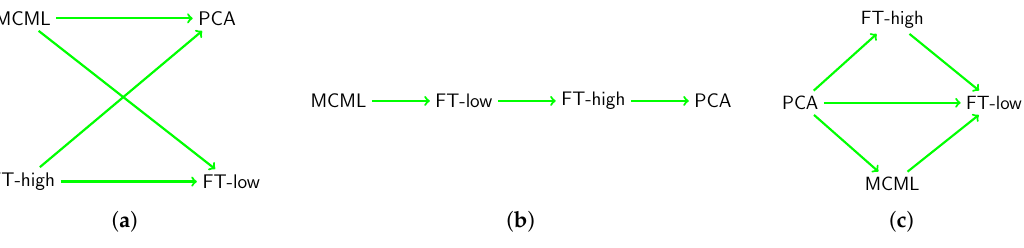
Figure 6. Significant results of paired t-tests for completion time. An arrow from condition A to condition B indicates that participants completed the tasks much faster under A than under B. ( a ) All Tasks; ( b ) Clustering; ( c )